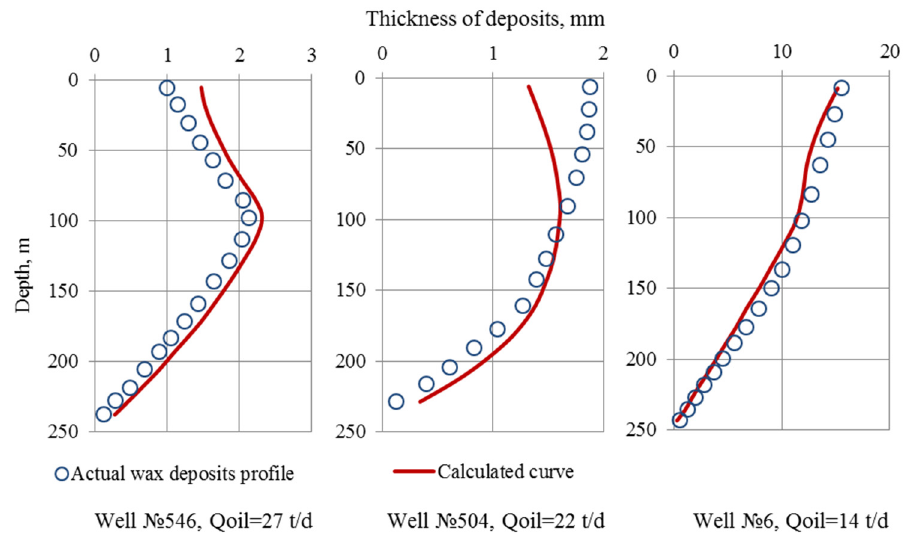
Figure 1. Profile of wax deposits along wellbores №№ 546, 504, and 6 in a Western Siberian oilfield (Russia).